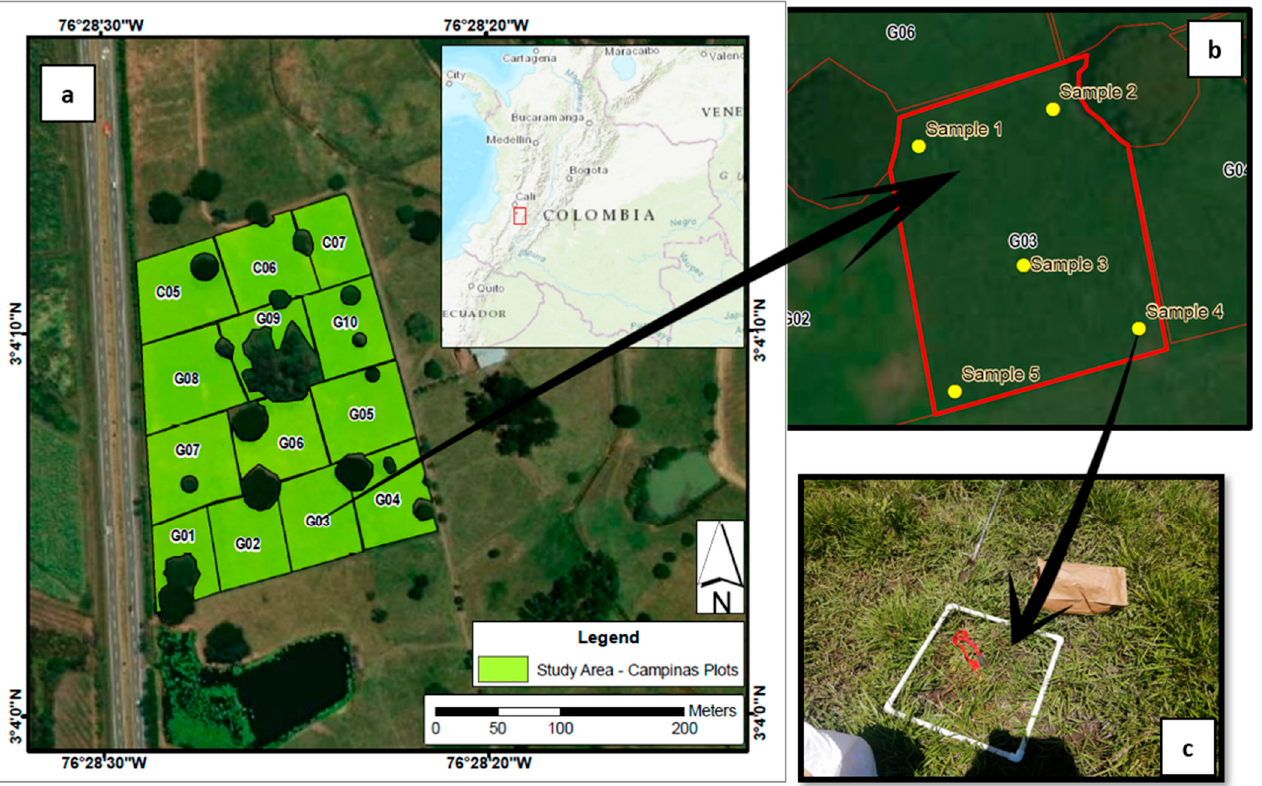
Figure 1. Study area. ( a ) The green polygons show each paddock or plot with its codes, excluding the tree regions (hole area). The map is in geographic WGS84 coordinate; ( b ) an example of each plot with the five samples taken; ( c ) the 0.25 × 0.25 m frames used to take each sample.